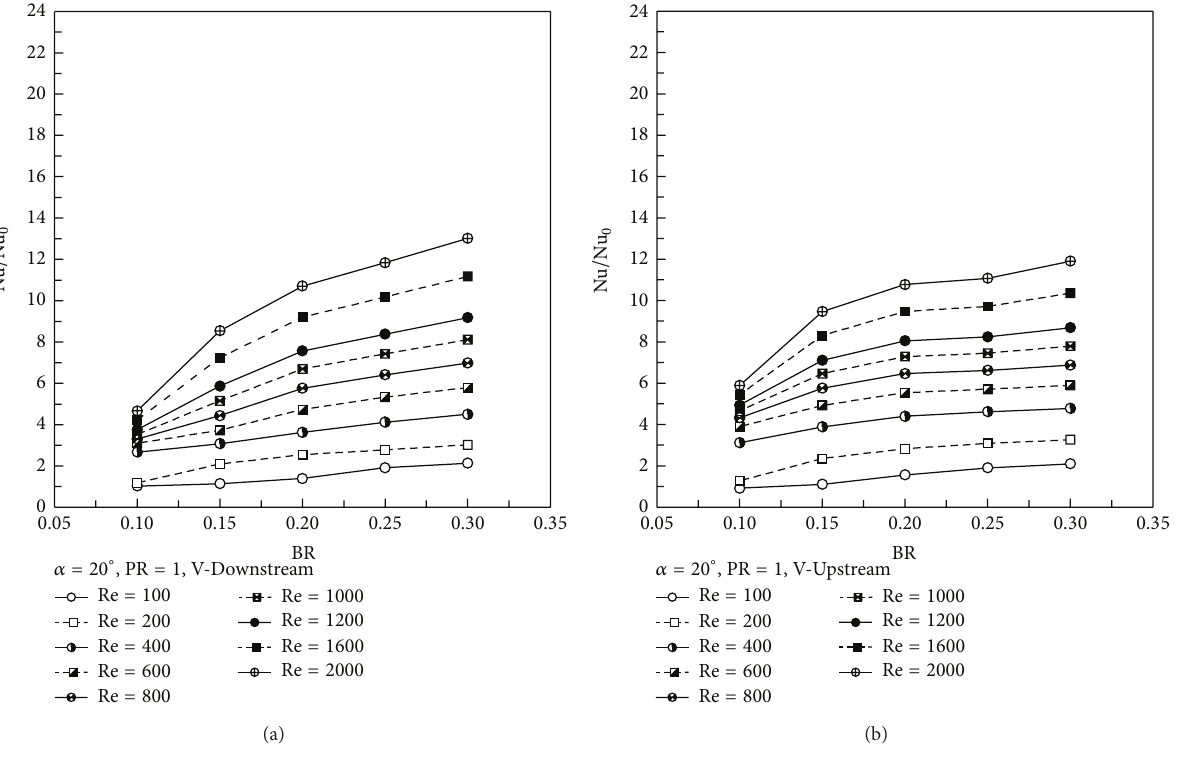
RLE: Rib leading